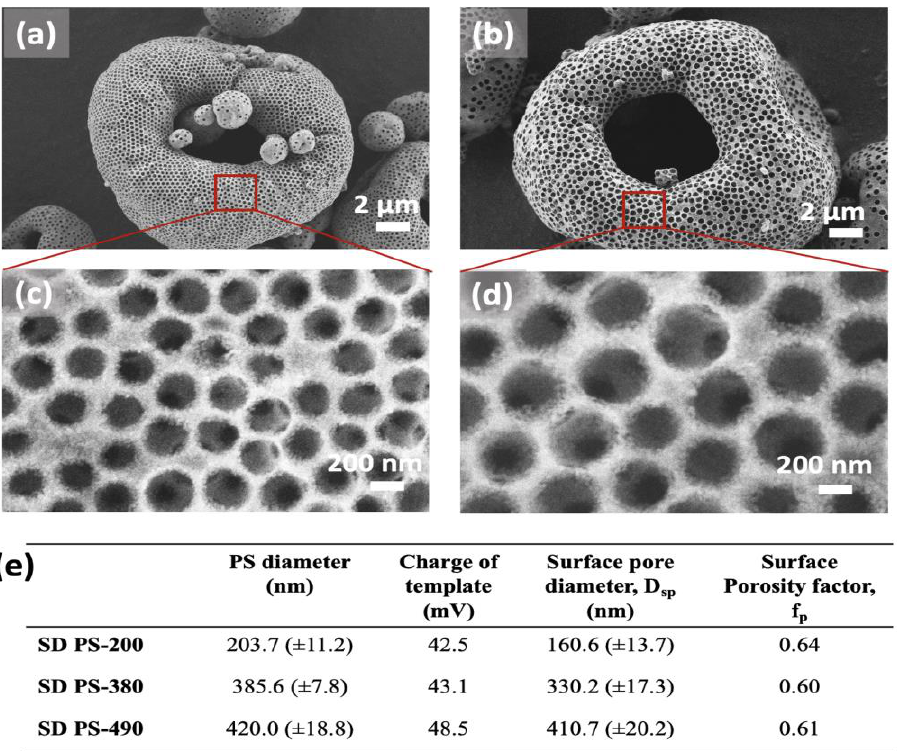
Figure 5. Control over pore diameter in SD microparticles using various sizes of PS templating colloids. ( a , b ) SEM images of RCT SD 0.4Pt@PS with PS sizes of 385.6 nm ( a , c ) and 420.0 nm ( b , d ), respectively. ( e ) Table summarizing the measured